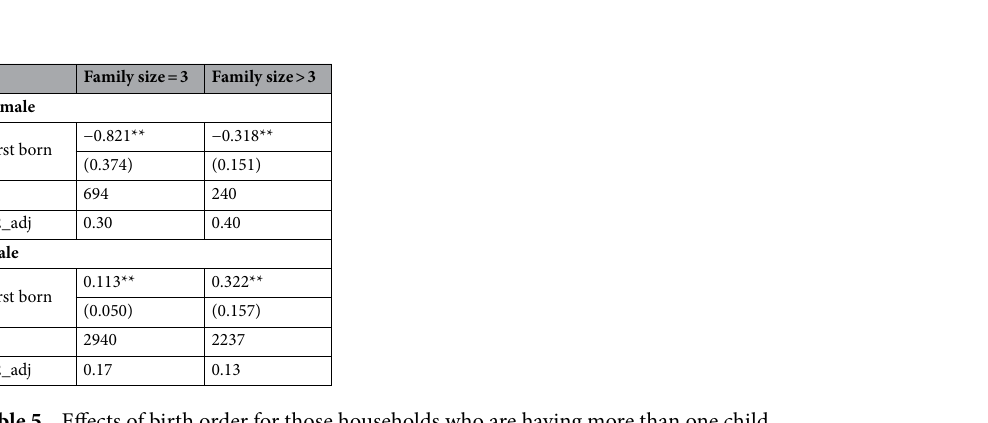
Table 5. Effects of birth order for those households who are having more than one